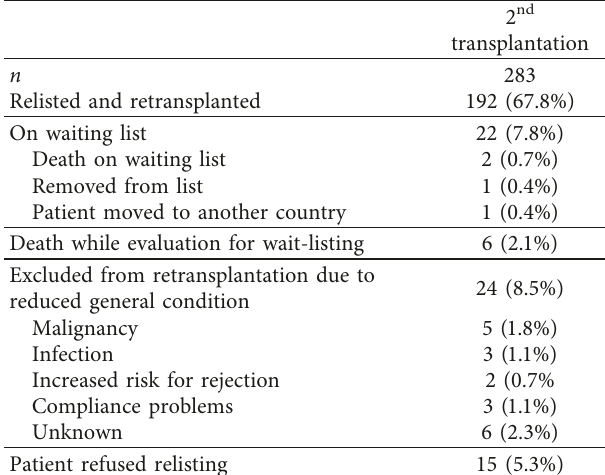
Table 2: Listing for